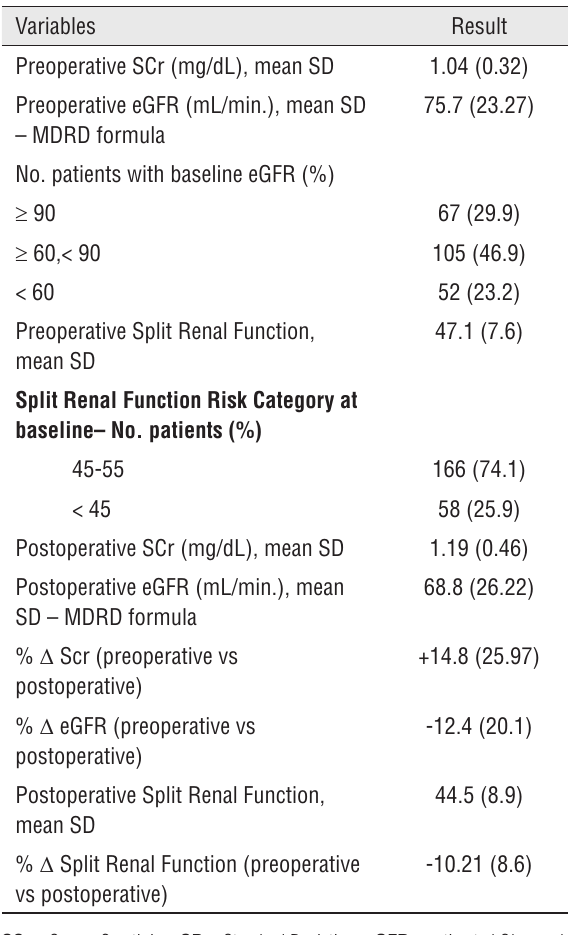
Table 2 - Renal function